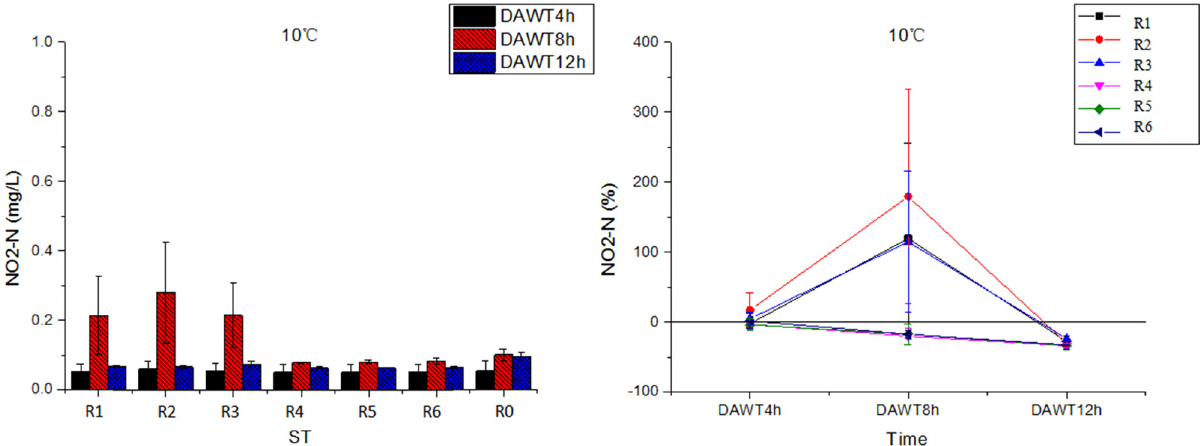
Figure 4: NO 2 – N varies with DWAT.